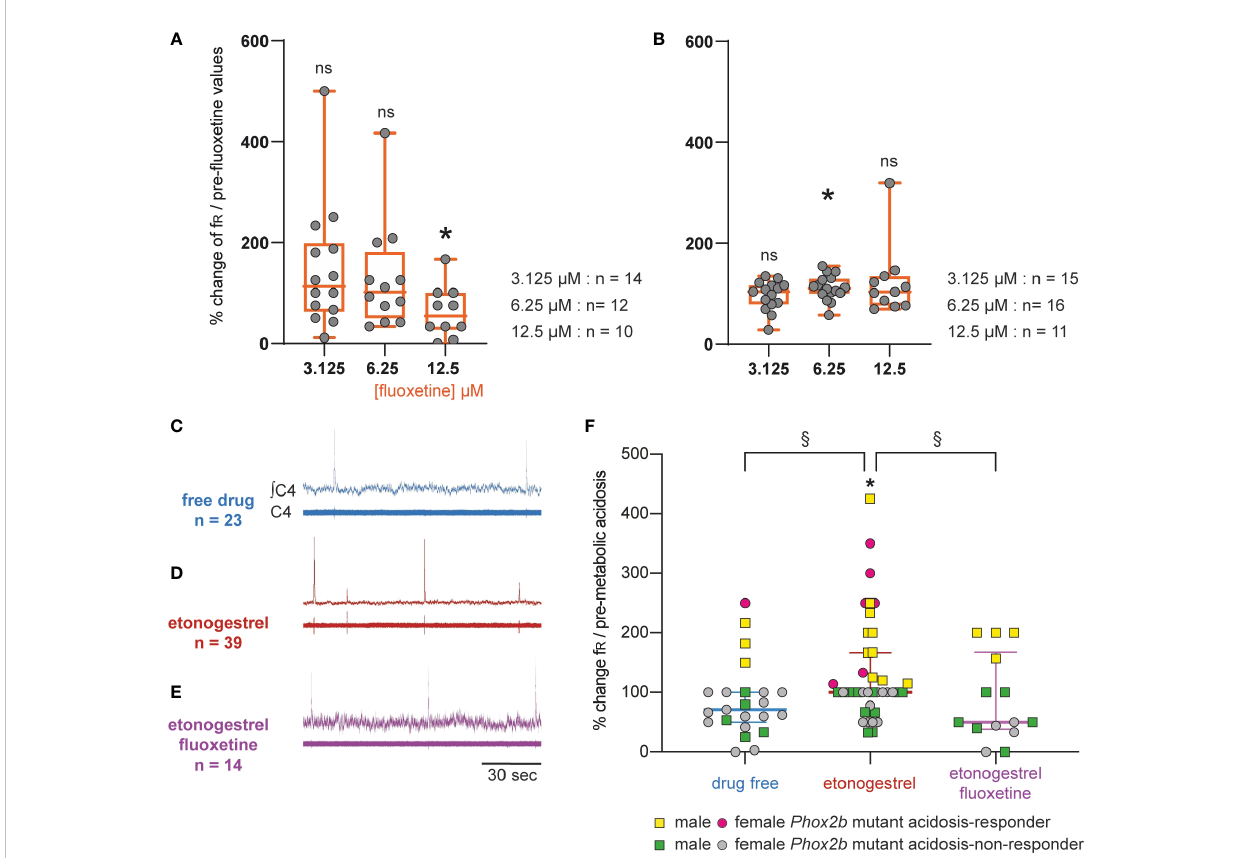
FIGURE 7 Effect of an increase in 5-HT signaling by fl uoxetine in Phox2b mutant mice. Scatter plots with a superimposed box and whisker plot (median [Q1; Q3]) showing percentage of change of fR under fl uoxetine in Phox2b mutants (A) and wildtype littermates (B) . In Phox2b mutants, 3.125 (n=14), 6.25 (n=12) and 12.5 µM (n=10) of fl uoxetine. In wildtype littermates, 3.125 (n=15), 6.25 (n=16) and 12.5 µM (n=15) of fl uoxetine. * p < 0.05 indicates a signi fi cant change in fR relative to pre- fl uoxetine values (paired t-test or Wilcoxon matched pairs signed rank test depending on the normality